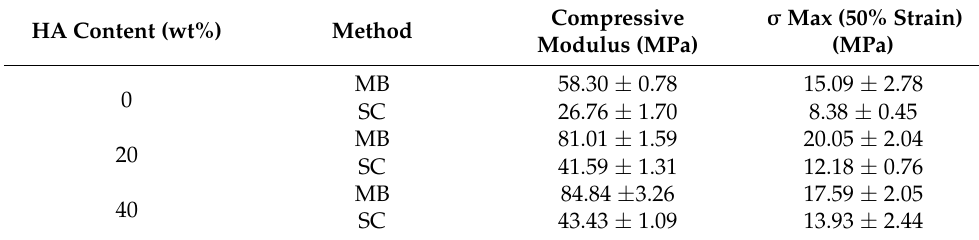
Table 2. Mechanical properties of compressive strength of